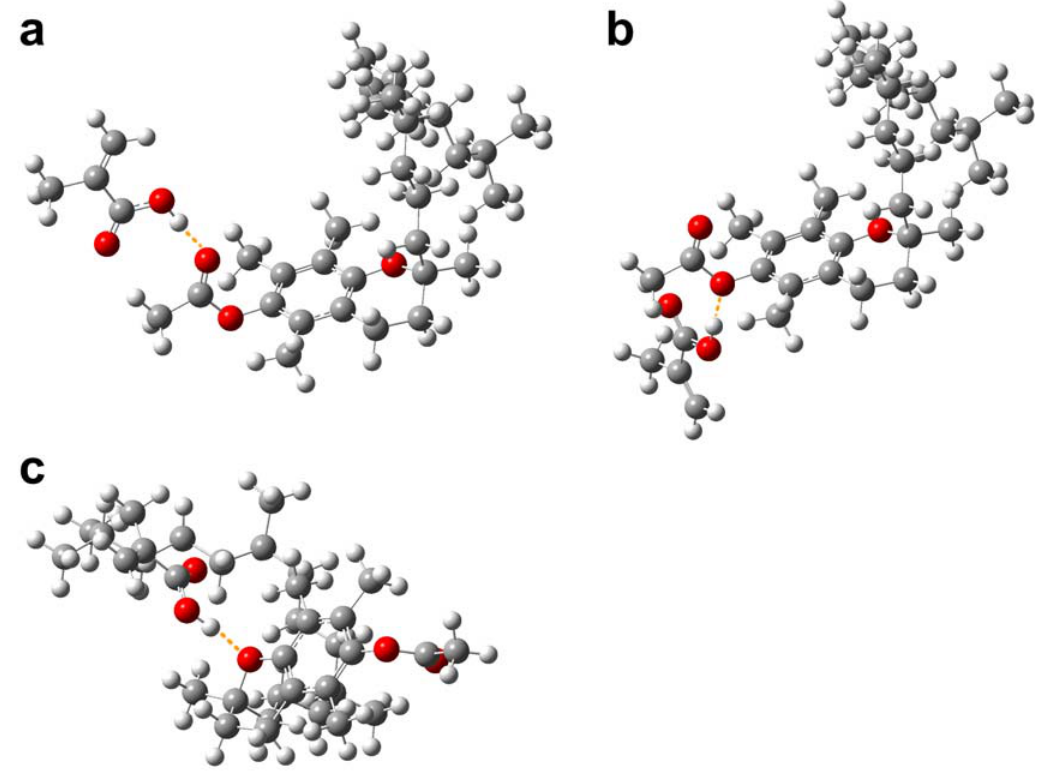
Figure 9. Possible modes of interaction of TPA with